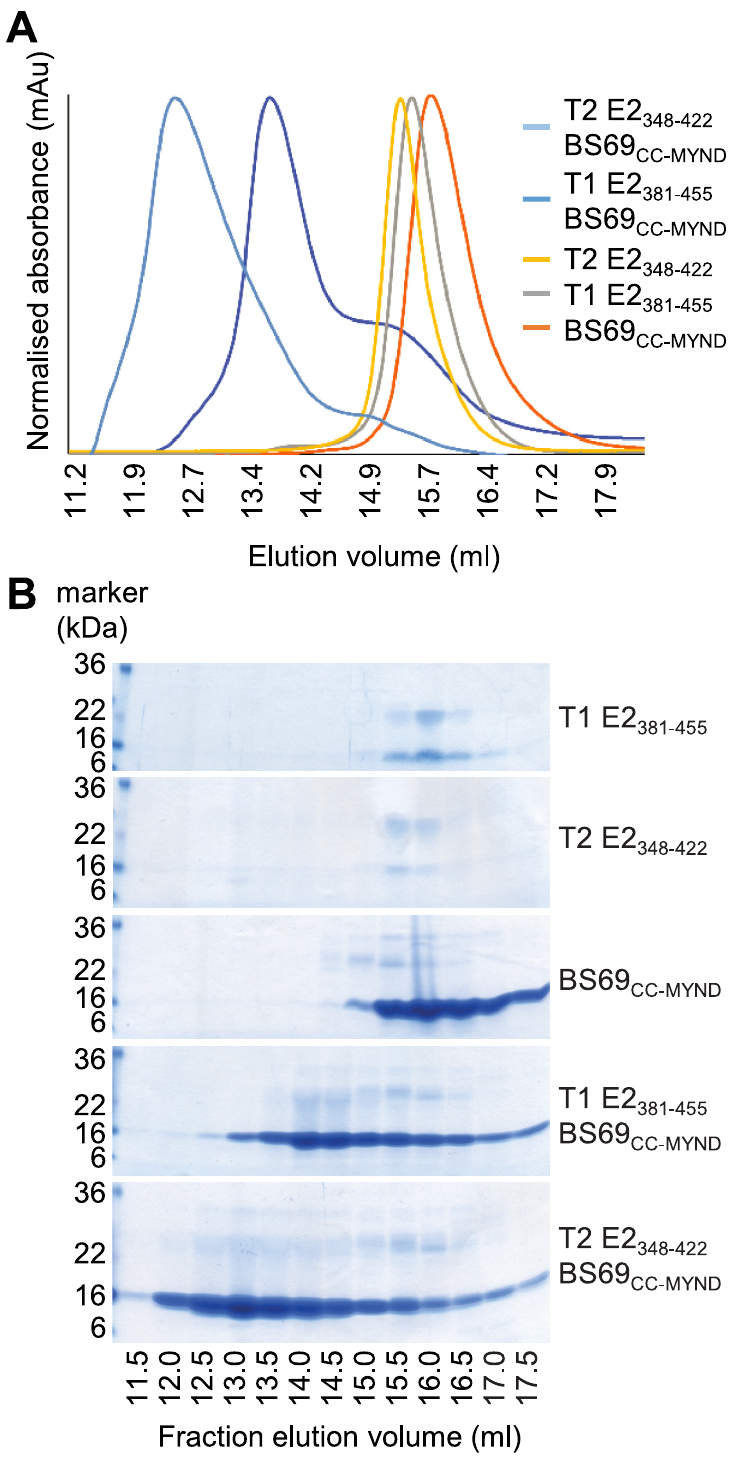
Fig 3. Solution state analysis of EBNA2 and BS69 CC-MYND complexes. (A) Size exclusion chromatography of individual type 1 and type 2 EBNA2 polypeptides, BS69 CC-MYND and EBNA2-BS69 CC-MYND complexes. Absorbance was normalized to the type2 EBNA2-BS69 complex (highest absorbance) using UNICORN software. (B) Samples from the indicated fractions were analysed by SDS-PAGE followed by Coomassie staining.